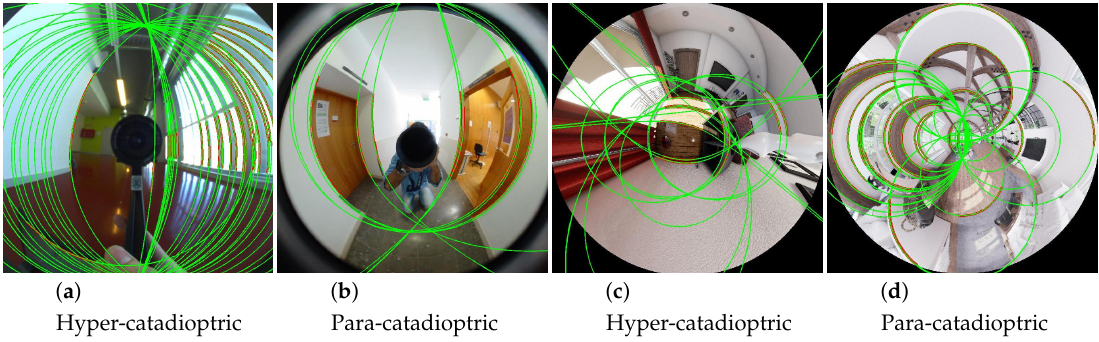
Figure 10. Line extraction on catadioptric systems. ( a , b ): Real catadioptric images from examples of [34]; ( c , d ): Synthetic images from our